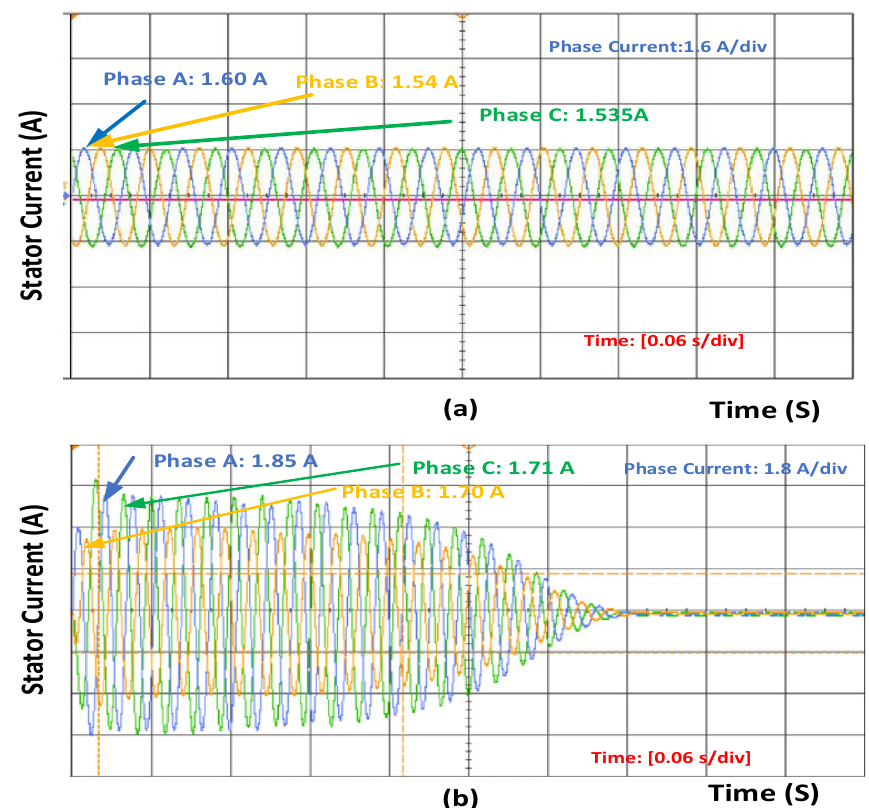
Figure 3. ( a ) Stator current in healthy condition for induction motor. ( b ) Stator current after 40% inter-turn fault in an induction